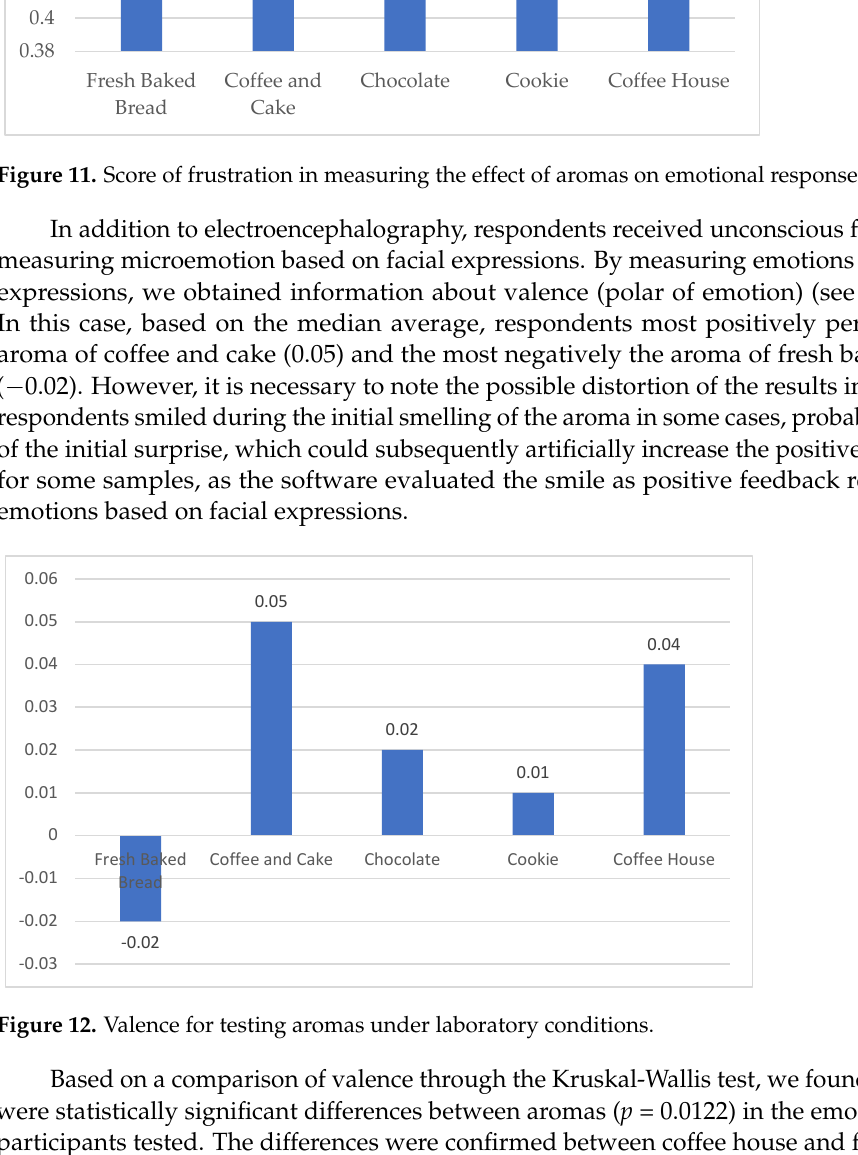
Figure 12. Valence for testing aromas under laboratory conditions.